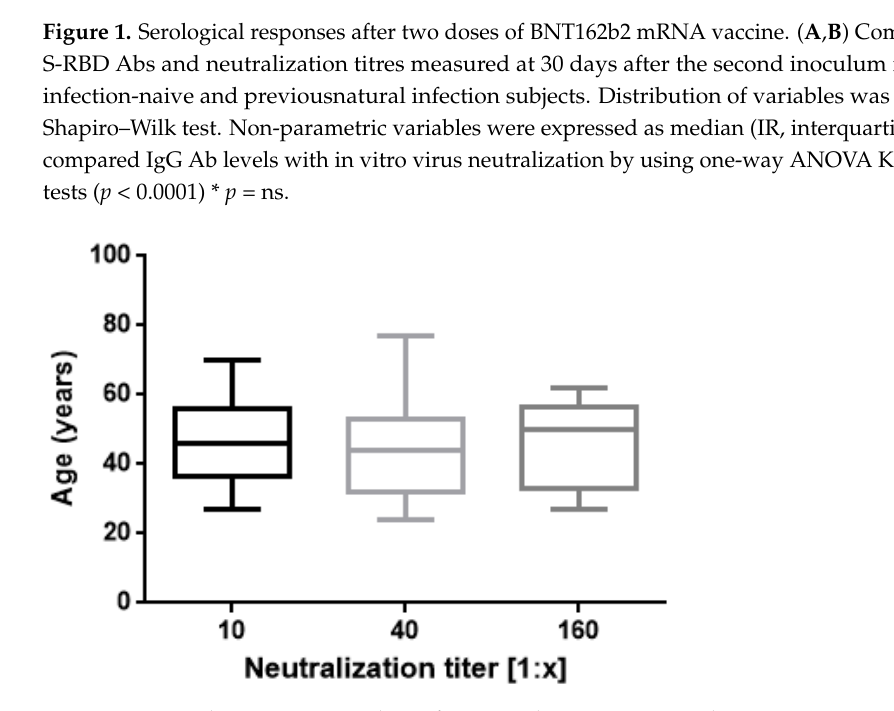
Figure 3. Serological responses after two doses of BNT162b2 mRNA vaccine. ( A – D ) Spearman’s correlation of post vaccine anti-S RBD antibodies levels and age, gender in infection-naive ( A , fe- males; B , males) and previously infected ( C , females; D , males) subjects with superimposed linear regression lines (95% confidence interval). The influence of gender, age and smoke on the trend of these results deserves further study. In fact, the number of participants who have been previously subjected to a natural infection is significantly lower than that of naive subjects; therefore, the first category is not adequately represented in all the age groups taken into consideration for this study. Despite this limitation, our data correspond with other recent studies [ 14,27 ] . When comparing participants afflicted by immuno-mediated diseases with healthy subjects among the whole group, significant differences in Ab levels were reported (Figure 4).